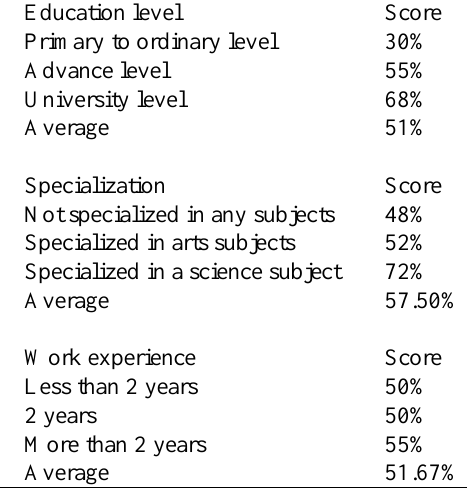
Table 4. The relationship between demographic profile and the packaging standard awareness.